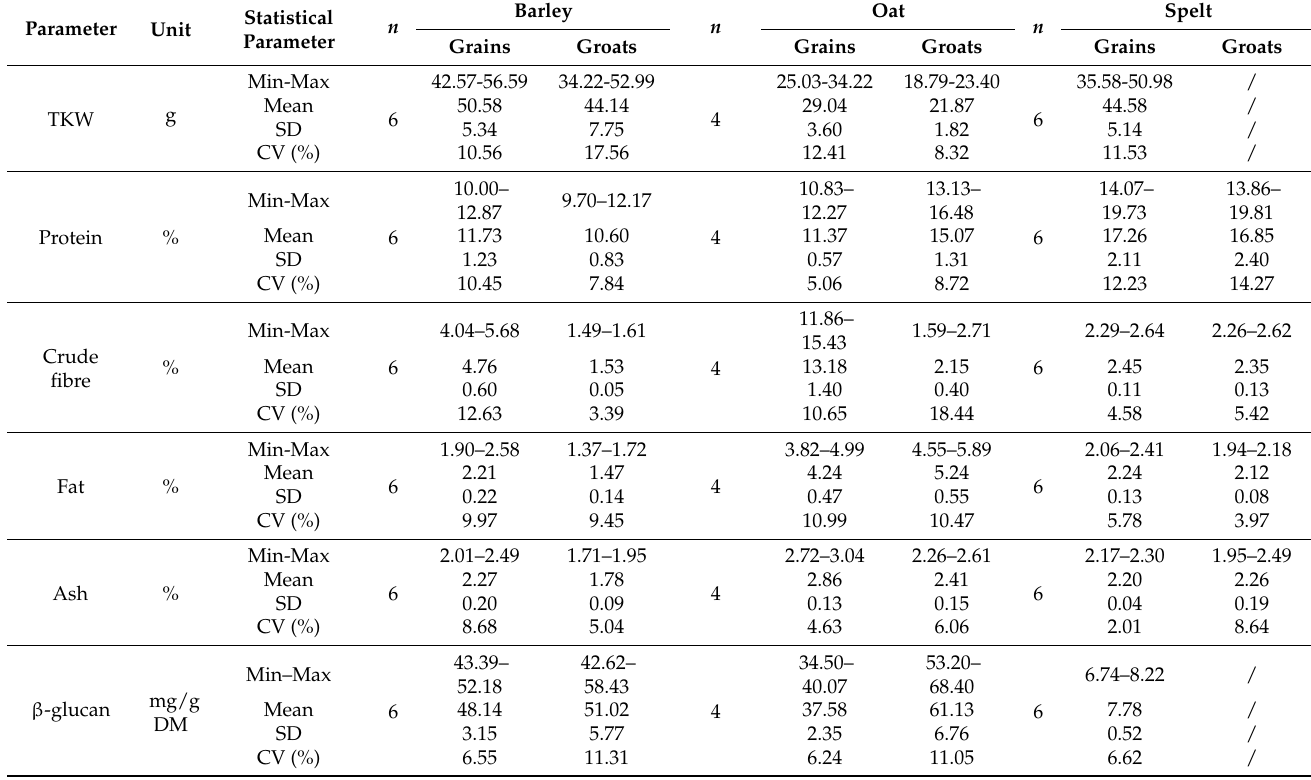
Table 2. The summary data of the compositional characteristics studied in the harvested grains and processed groats of barley, oat, and